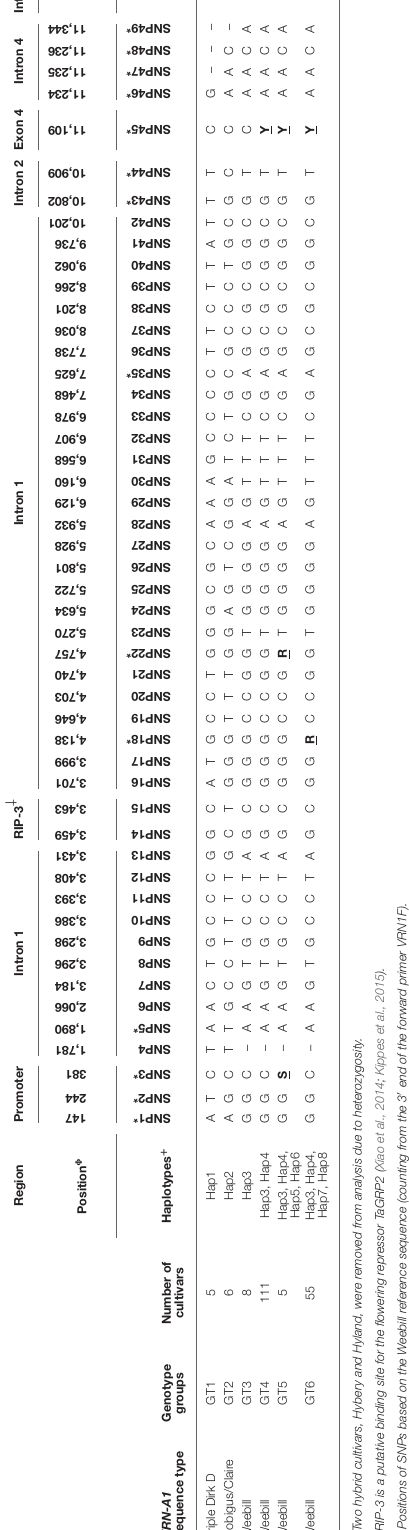
( Table 3 ). SNP18 located in intron 1 and SNP45 located in exon 4 showed an unexpectedly high frequency of heterozygous calls across cultivars, 29 and 90%, respectively. We developed two robust KASP markers (VRN5A-SNP18K and VRN5A-SNP45K) targeting these two SNPs within the VRN-A1 gene. Surprisingly, the cluster plot of VRN5A-SNP45K KASP assay in exon 4 showed two distinct heterozygous clusters ( Figure 4B ). Cluster 2 (CT) is including all 55 cultivars carrying the combination of two alleles G/A at SNP18 ( Figures 4A,B ), while cluster 3 (CT) includes 107 cultivars carrying the G allele at SNP18 ( Figures 4A,B ). Based on this comparison we hypothesized that a dosage effect (gene copy number effect) for the T and C allele at SNP45 within exon 4 could be responsible for the formation of two distinct heterozygous clusters for the VRN5A-SNP45K assay. To investigate the allelic composition at SNP45, we computed the frequency of the mapped ONT reads supporting each allele using of the T allele in cultivars of cluster 3 ( ∼ 70% in average) is higher than in those of cluster 2 ( ∼ 50% in average), with a strong significant difference ( P -value > 2.2e-16). Based on this finding we hypothesize that cultivars of cluster 3 (CT) contain a higher number of VRN-A1 copies with the T allele than those copies with the C allele. This current finding is supported